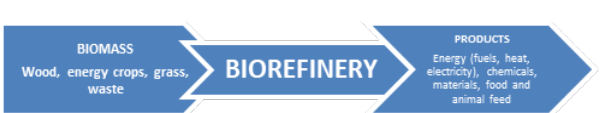
Fig. 3. The idea schema of biorefinery